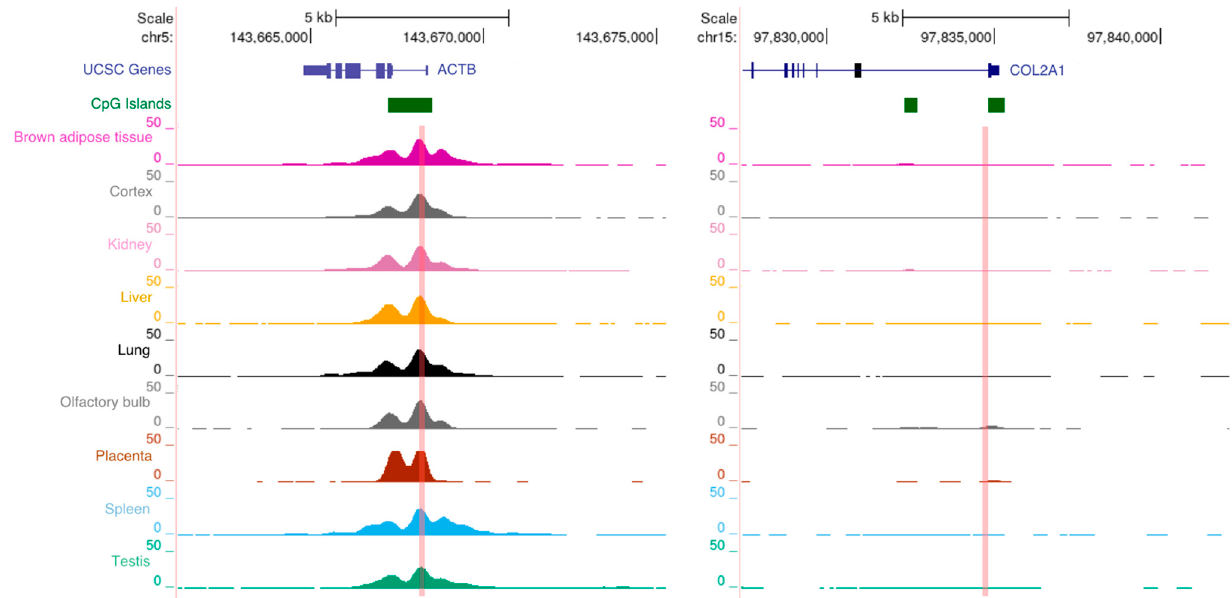
Figure 3. Identification of H3K4me3 control regions for the evaluation of the specificity of the immunoselection by real-time qPCR. Regions known to be enriched or not enriched can be used for antibody titration and to evaluate the specificity of the immunoselected DNA prior to library preparation and sequencing. Snapshots of mouse H3K4me3-enriched ( ACTB ) and not enriched ( COL2A1 ) gene promoters are shown as example. ChIP-Seq data are from the ENCODE project and were taken from UCSC Genome Browser (http://genome.ucsc.edu (accessed on 7 November 2021)). The sequences we used to amplify as a control of specificity of H3K4me3 experiments on mouse tissues are indicated by the light-red vertical bars.